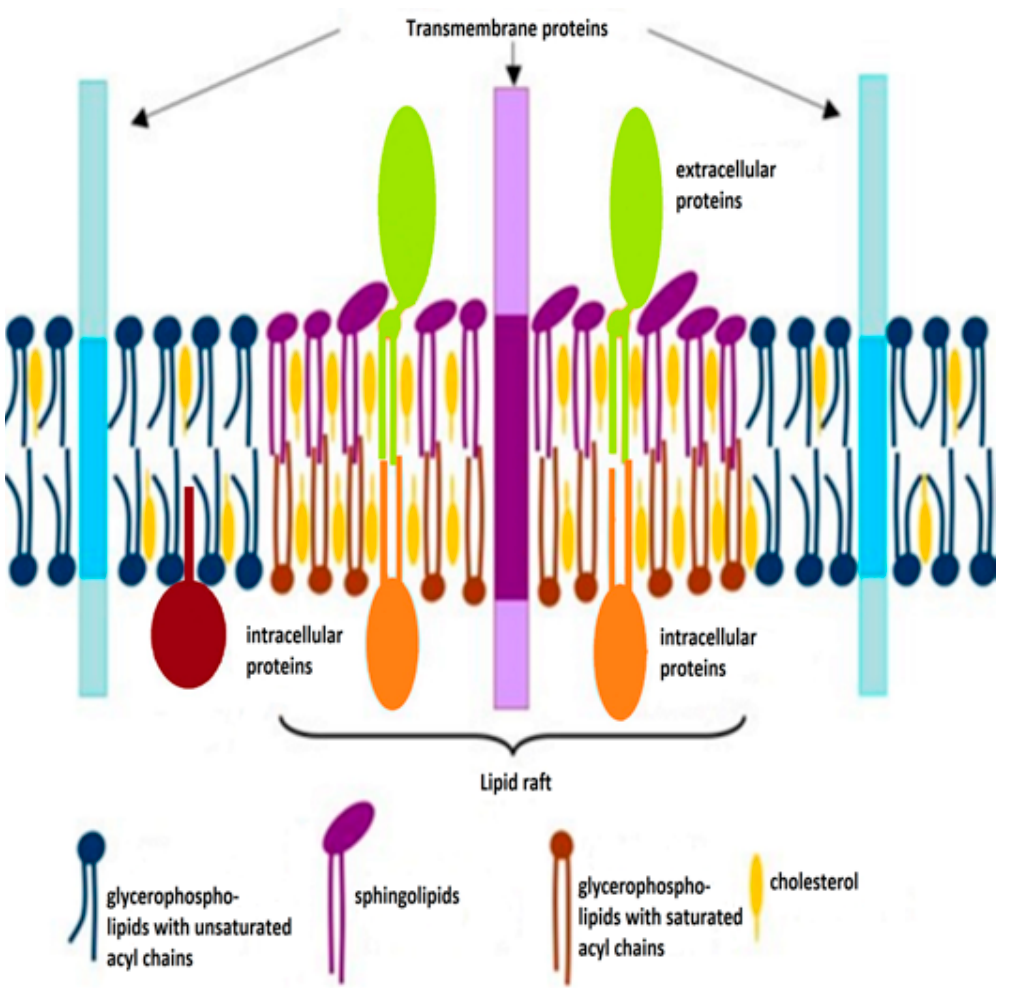
Figure 1. A simplified model of lipid rafts in cell membranes. Cholesterol is abundant in the lipid raft microdomain, where the acyl chains of lipids are generally longer and saturated, as opposed to the acyl chains of non-raft phospholipids, which are unsaturated and shorter.